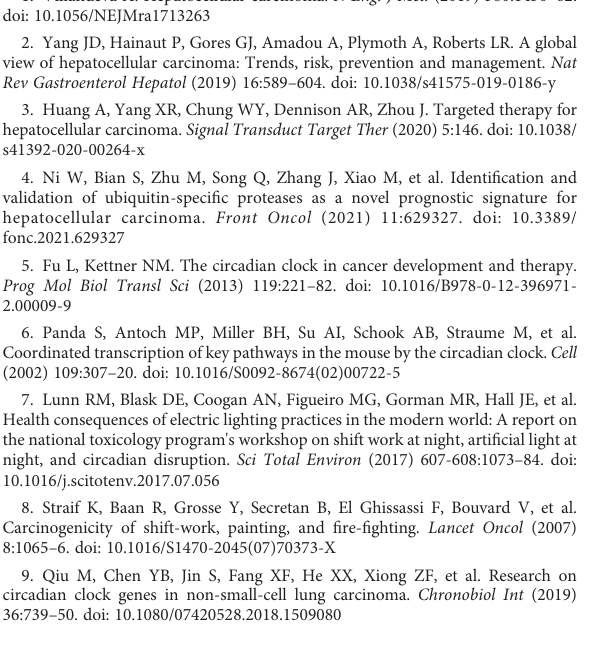
SUPPLEMENTARY FIGURE 1 The Human Protein Atlas (HPA) database was used to validate the circadian genes CRY2 and CSNK1D. No data for FBXL21 or PER1 was available in the HPA